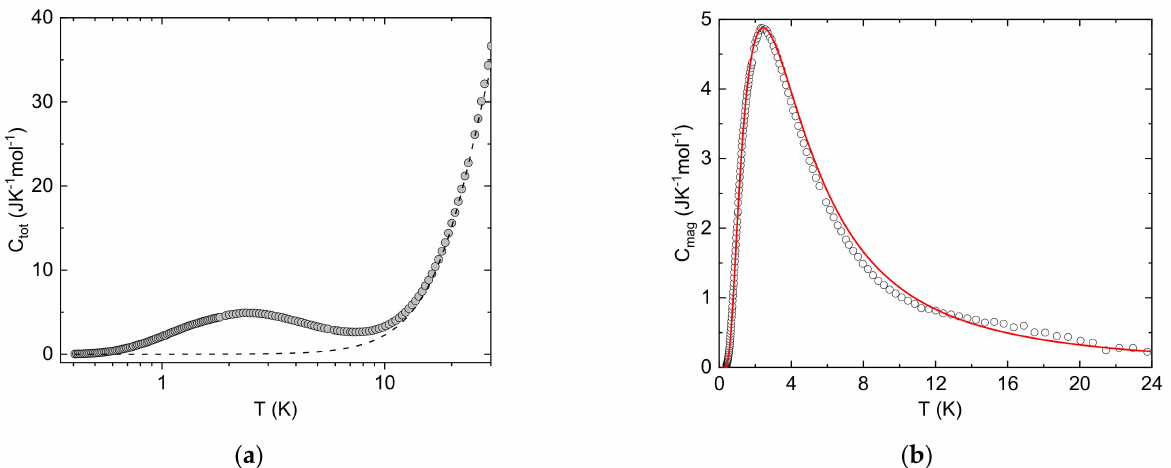
Figure 3. ( a ) Temperature dependence of total specific heat of NiHmal in a zero magnetic field (symbols). The dashed line represents the lattice contribution to the specific heat; ( b ) Temperature dependence of magnetic specific heat of NiHmal in a zero magnetic field (symbols). The solid line represents the theoretical prediction for S = 1 paramagnet with D / k B = –7.82 K, E / k B = –2.15 K, and g =